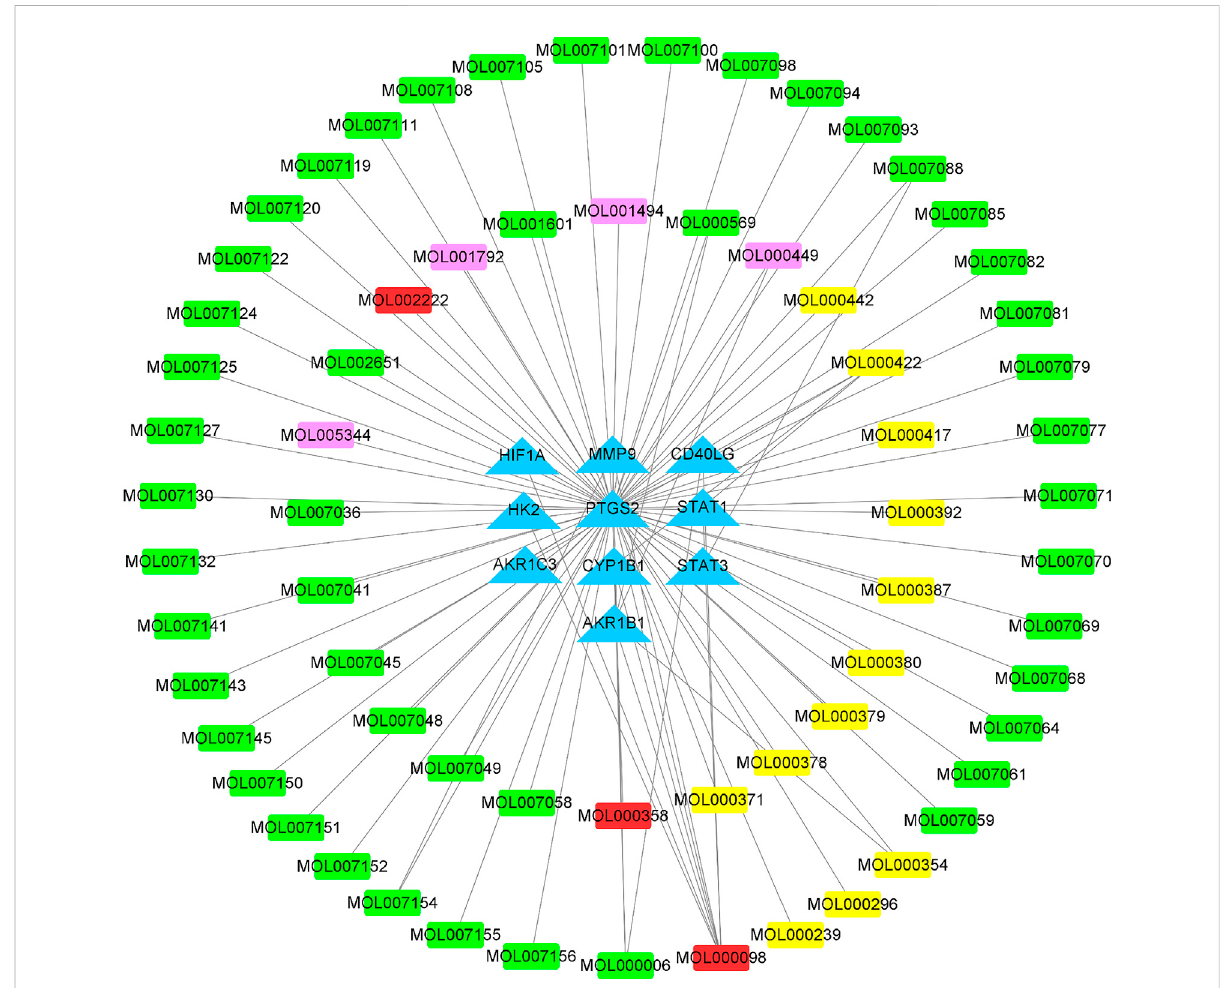
FIGURE 4 Compound – disease network of FFXST. Green, yellow, and pink squares represent the compounds from Danshen, Huangqi, and Sanqi, respectively; red square represents the multidrug; and blue triangles represent targets.